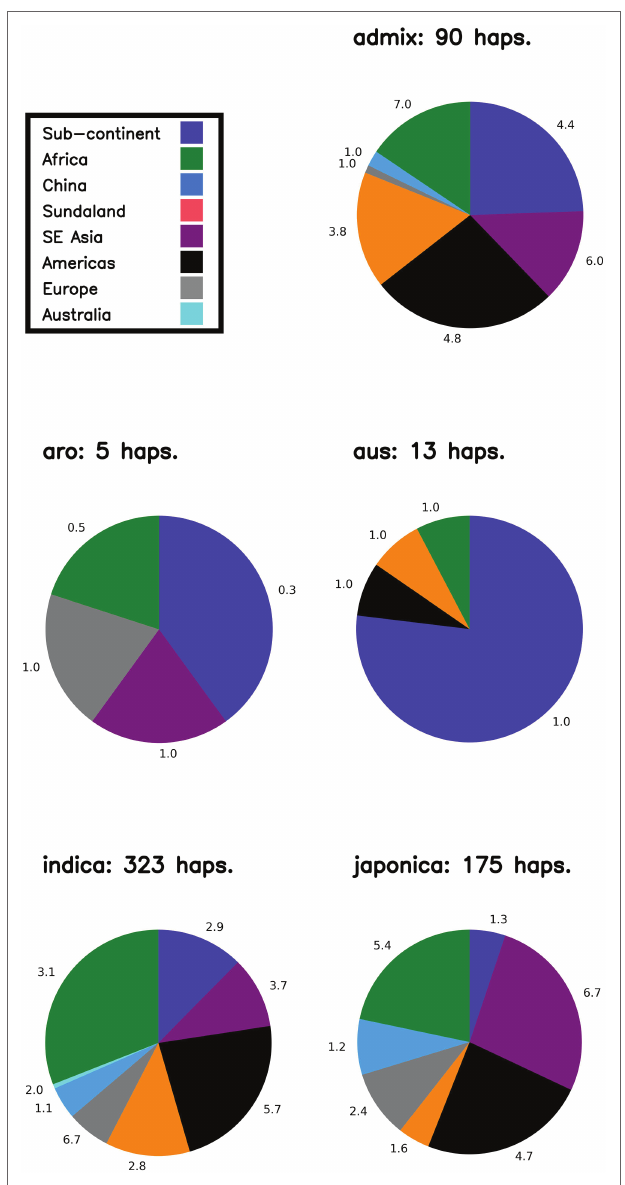
FIGURE 4 | Likely origins of identified large grain size haplotypes on Chromosome 7. Proportions indicate geographic origins of accessions in the 3KRG database, according to rice variety group, of novel identified haplotypes (i.e., LGHs identified in 3KRG varieties). Numbers adjacent to segments indicate number of haplotypes per accession (i.e., to control sampling bias) from that region. NB Sundaland indicates the Indo-Pacific region; sub-continent indicates South Asia